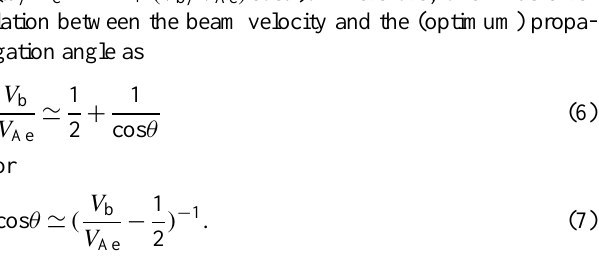
Fig. 4. (a) Optimum growth rate, (b) related (real) frequency and (c) propagation angle θ as a function of the beam velocity V b /V Ae ; n b /n o = 0 . 01. With higher beam velocity the growth rate increases and the propagation angle θ shifts closer to 90 ◦ . The relations (b) and (c) can be expressed analytically by Eqs. (5) and (7), respec- tively.